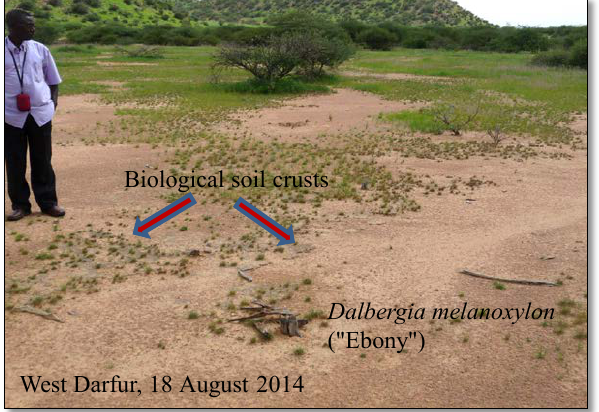
Figure 10. Residuals of initially dense Dalbergia melanoxylon